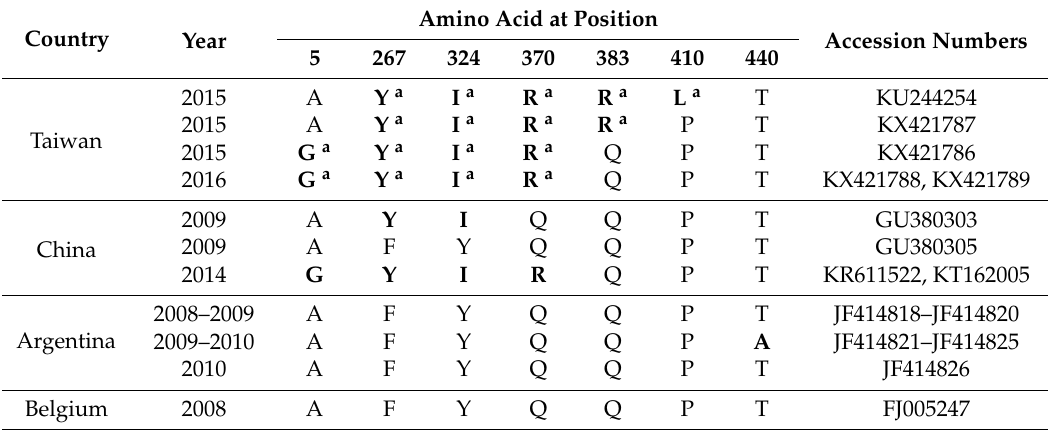
Table 1. Characteristics of the Amino Acid Substitution of CPV-2c